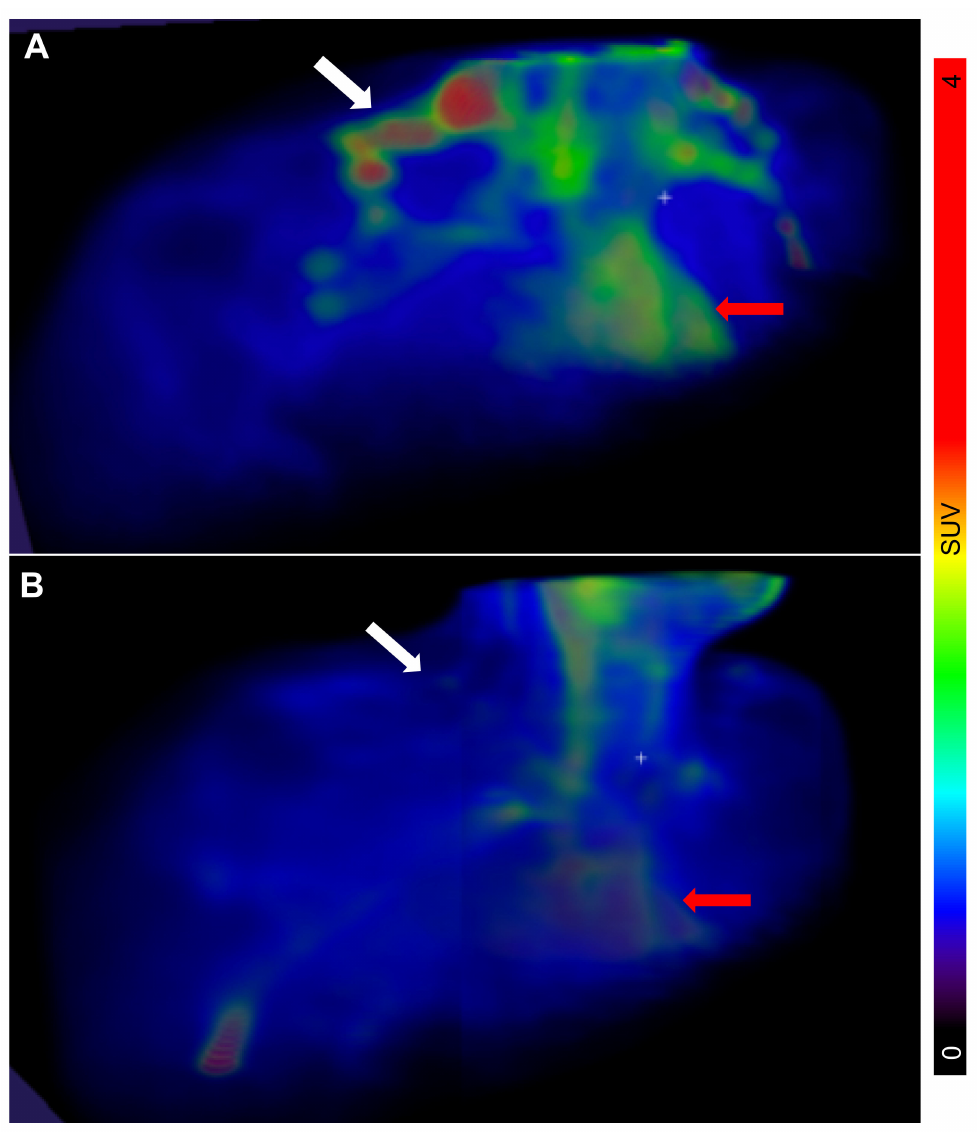
Figure 1. 3D maximum intensity projections of the biodistribution of 2-deoxy-2-( 18 F)fluoro-D-glucose ( 18 F-FDG) in the neck region, following cold stimulation. The location of the supraclavicular regions where brown adipose tissue (BAT) is usually located is indicated by white arrows. Heart is indicated by red arrows. There was a marked intersubject variability in 18 F-FDG uptake, i.e., activated BAT, in the enrolled individuals with type 1 diabetes (T1D), ranging from very high ( A ) to low or absent ( B ). Representative images are shown. The scale bar to the right shows the colour coding from SUV 0 to 4. The metabolic activity of WAT was found to correlate with fasting glucose levels ( r = 0.73, p = 0.01) but not with HbA1c ( p = 0.49). However, metabolic activity of WAT did not correlate to insulin requirements, markers of body composition, or investigated hormones / cytokines. The metabolic activity of WAT and skeletal muscle were correlated ( r = 0.89, p =